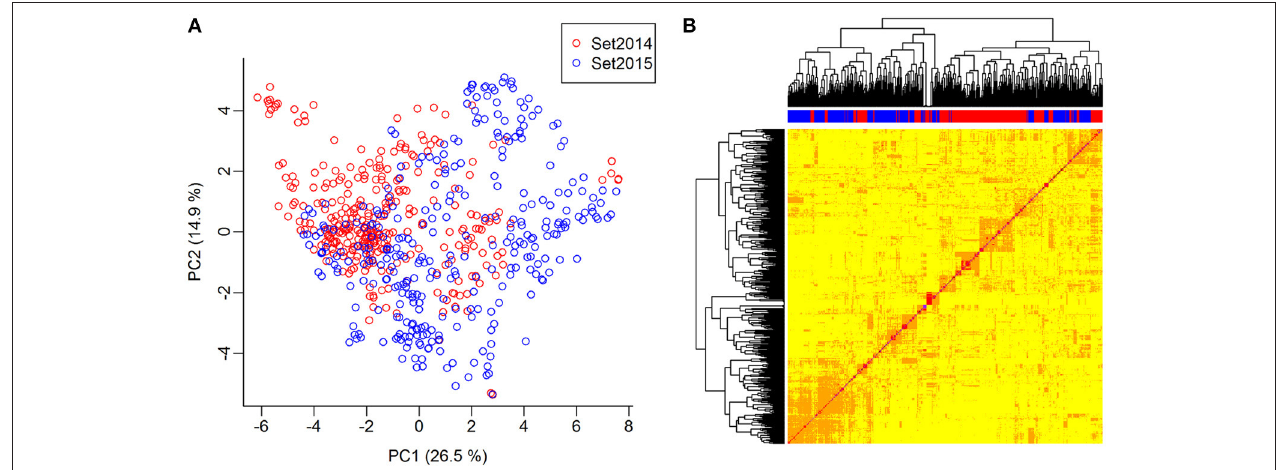
FIGURE 3 | Genomic relationship between lines. (A) Principal component analysis of the G-matrix for the 635 lines. Plot of principal components 1 and 2, which explain 26.9 and 14.6% of the variance, respectively. Lines from set2014 are displayed in red, while lines from set2015 are displayed in blue. (B) Heat map and dendrogram of G-matrix showing the relationship between the 635 lines based on the genotyped SNP markers. The bar on top of the heat map shows, which set the lines, are from: Red: Lines from set2014, blue: Lines from set2015.